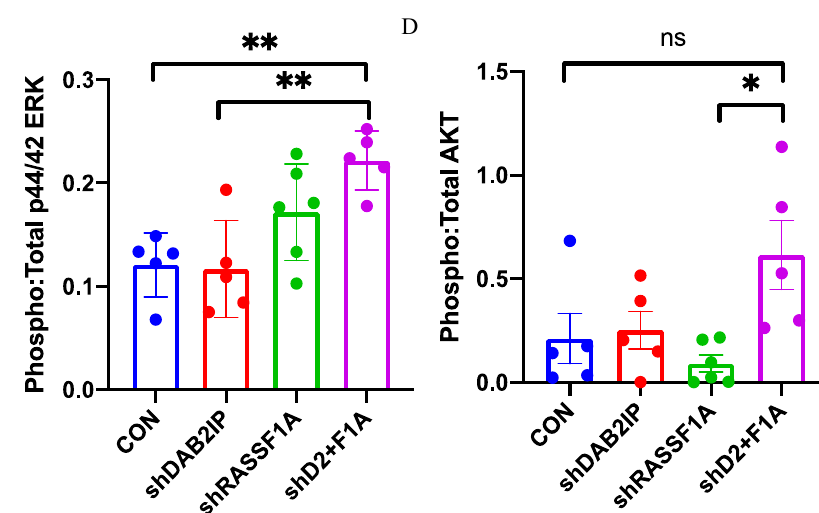
Figure 5. Effects of RASSF1A and DAB2IP suppression on in vivo growth and signaling. ( A ) NCI-H1437 xenograft growth curve. ( B ) Western blot analysis of RAS pathway activation in tumor lysates. ( C , D ) Densitometric analysis of MAPK pathway and PI3K-AKT pathway activation , respectively. Phospho and total protein images were obtained from the same nitrocellulose membrane. n = 5 or 6. * p < 0.05, ** p < 0.01, **** p < 0.0001, one-way ANOVA with Tukey’s test.